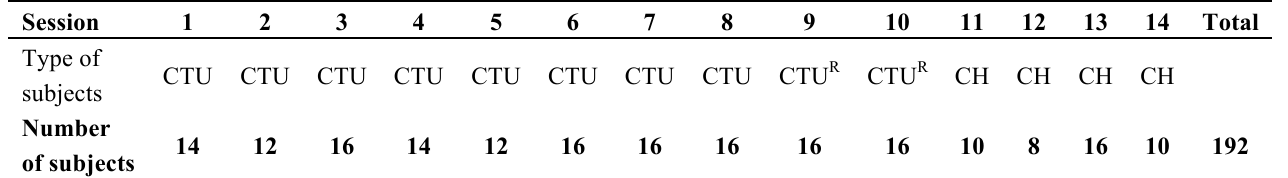
Table 2. Overview of experimental sessions.